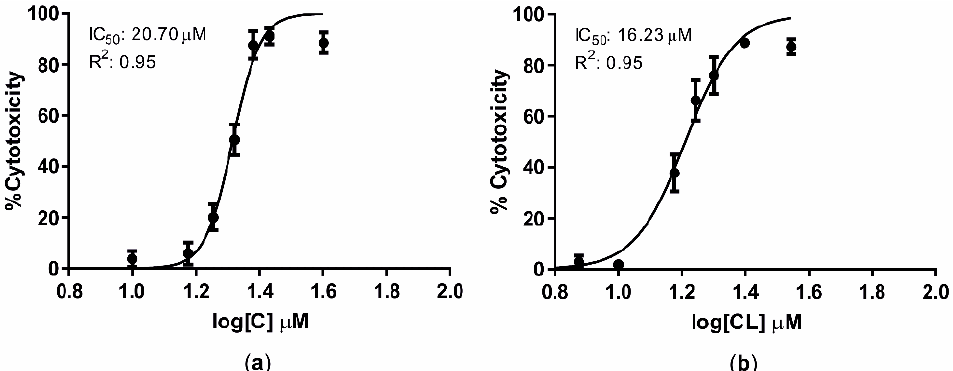
Figure 2. Dose–response curves of C ( a ) and CL ( b ) after the incubation of BFH12 cells for a total of 64 (16 + 48) h. Graphs were obtained by means of GraphPad prism software and using three independent cell culture experiments, each one run in sextuplicates. Data are expressed in mean cytotoxicity rate ± mean standard error (SEM). IC 50 and R 2 are also reported. C = curcumin; CL = Curcuma longa .